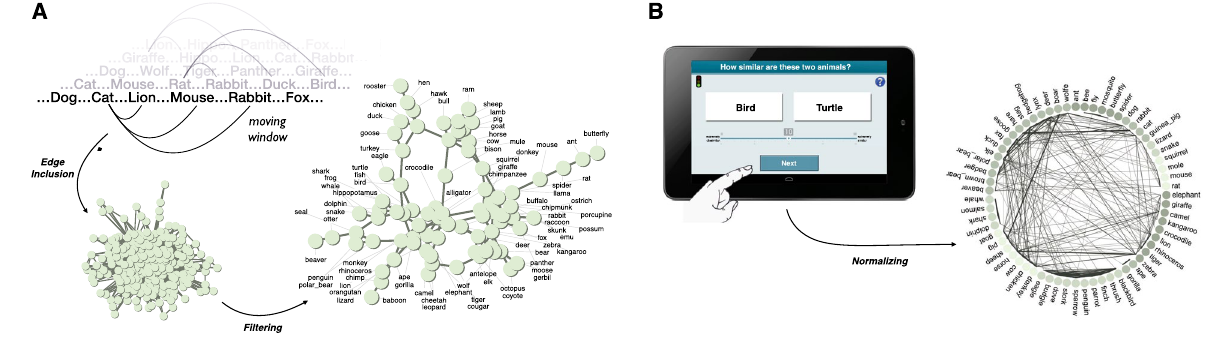
Figure 1. Methodological approach. Panel ( A ) illustrates the two steps, edge inclusion and filtering, involved in inferring networks from semantic fluency sequences. For details see Materials and Methods. The resulting network is based on 142 sequences of the older adults’ group of study 1. To simplify the visualization more conservative inferences settings were employed than used in the analyses reported below. Panel ( B ) illustrates the creation of networks from similarity ratings by normalizing individuals’ responses to the range of 0 and 1. The weighted network is based on the average ratings of the older adults’ group of study